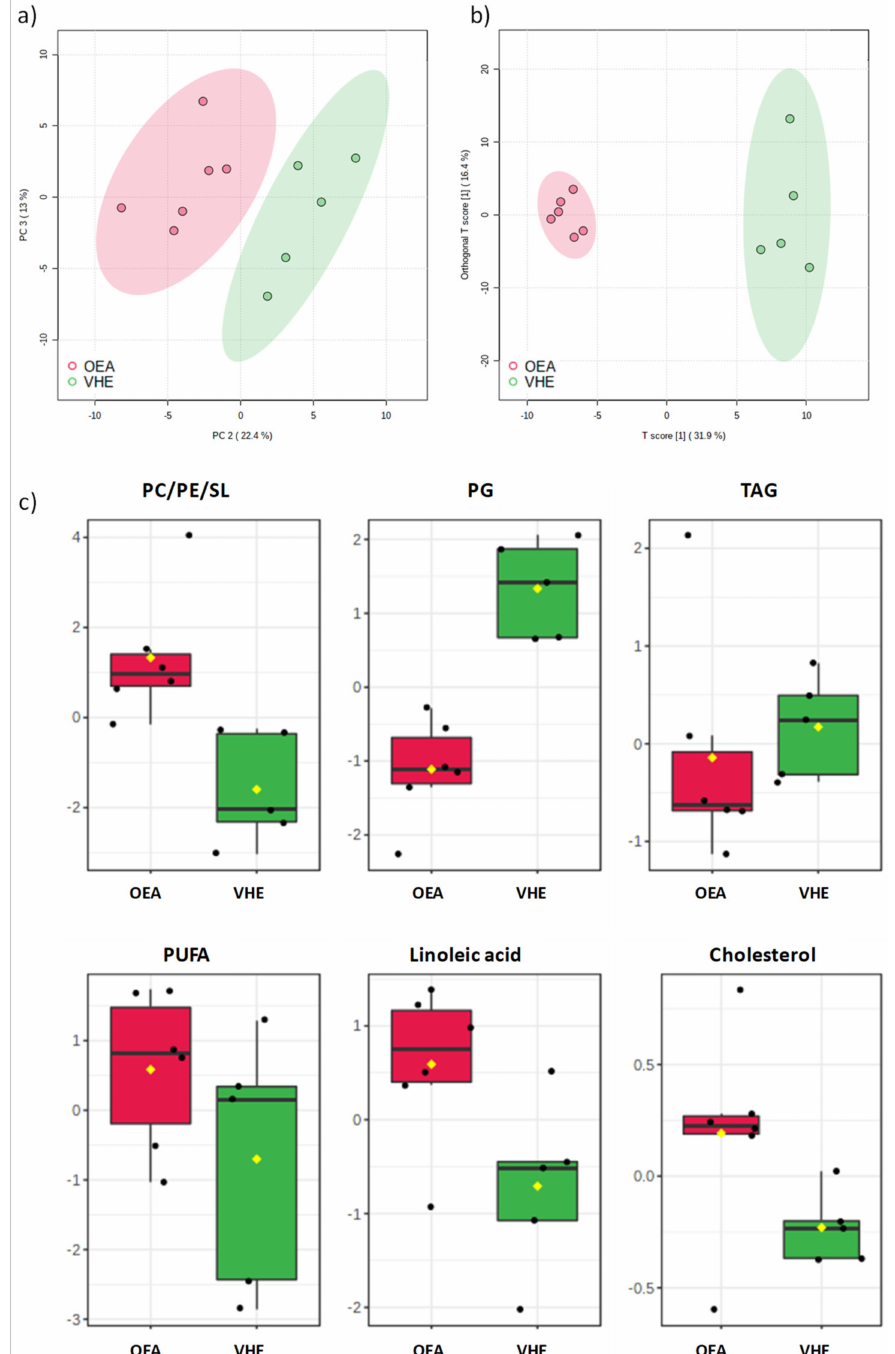
Figure 1. ( a ) Principal component analysis (PCA) score plot for OEA and VEH samples. ( b ) t[1]/to[1] orthogonal partial least squares discriminant analysis (OPLS-DA) score scatter plot for OEA and VEH samples, and ( c ) discriminant metabolites between the two groups are reported in the corresponding box and whisker plots, which summarize the normalized bucket values. The mean value for each group is indicated with a yellow diamond, while the notch indicates the 95% confidence interval around the median of each group, with dots placed past the line edges to indicate outliers. PC = phos- phatidylcholine; PE = phosphatidylethanolamine; SL = sphingolipids; PG = phosphatidylglycerol; TAG = triacilglycerols; PUFA = polyunsaturated fatty